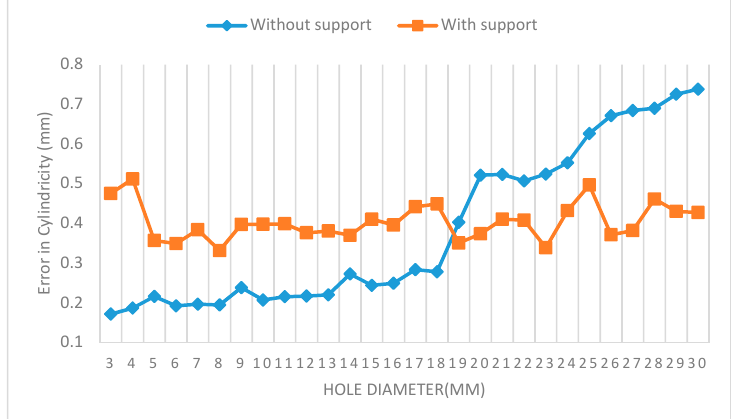
Figure 15. Cylindricity of 5-mm-thick holes with and without support structures.